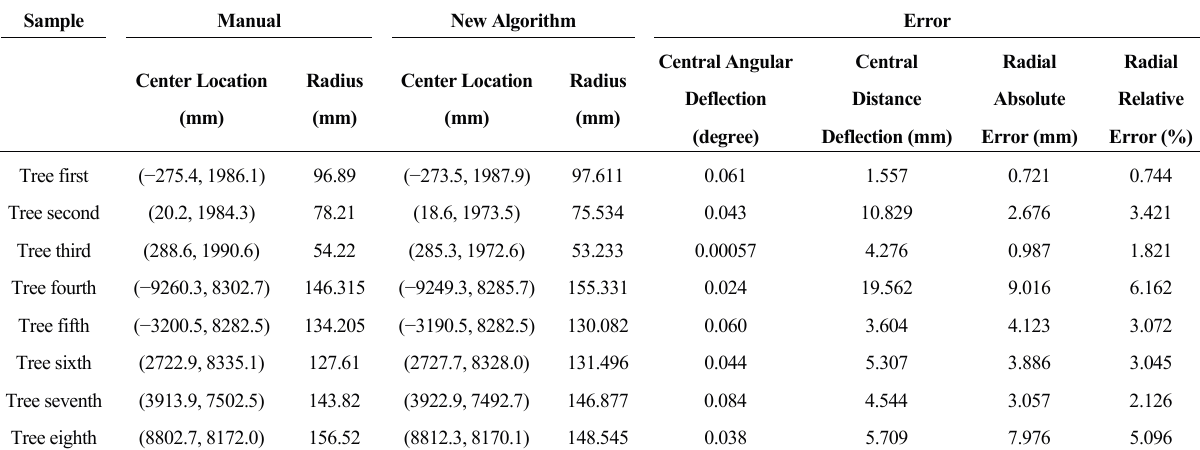
Figure 9. The fitting results of the trunk with laser clouds acquired by 2DTLS. Table 2. Parameters of the trunks acquired by different methods and the corresponding